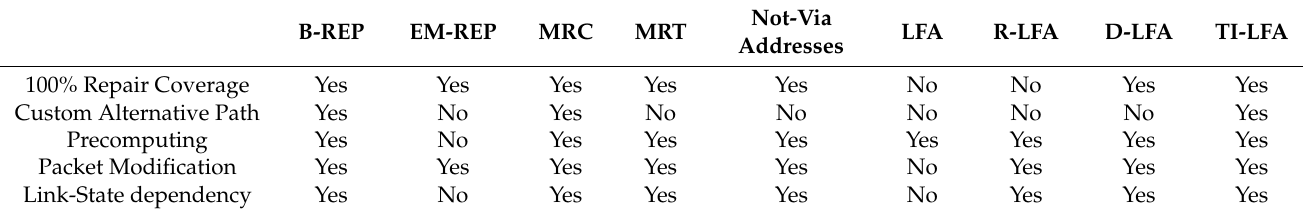
Table 1. Comparison of existing FRR solutions.